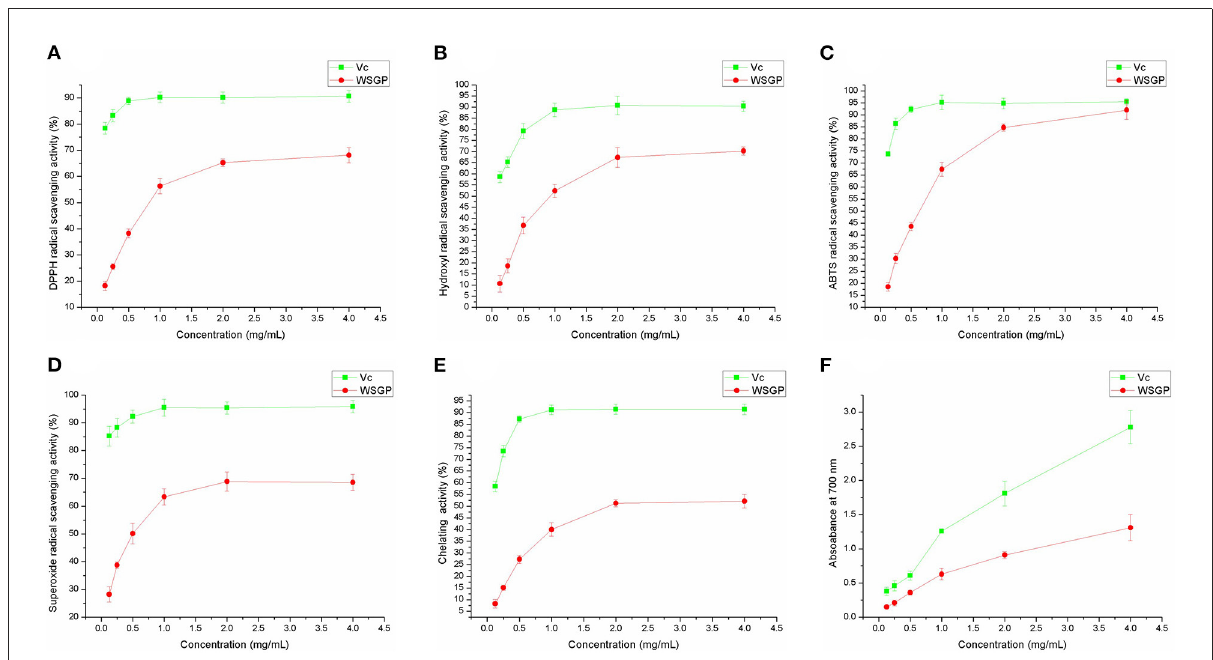
FIGURE3 The antioxidant abilities of WSGP include DPPH (A) , ABTS (B) , hydroxyl (C) , and superoxide (D) radical scavenging powers, chelating ability on Fe 2 + (E) , and reducing power (F) . The data were expressed as means ± SD from three independent experiments.